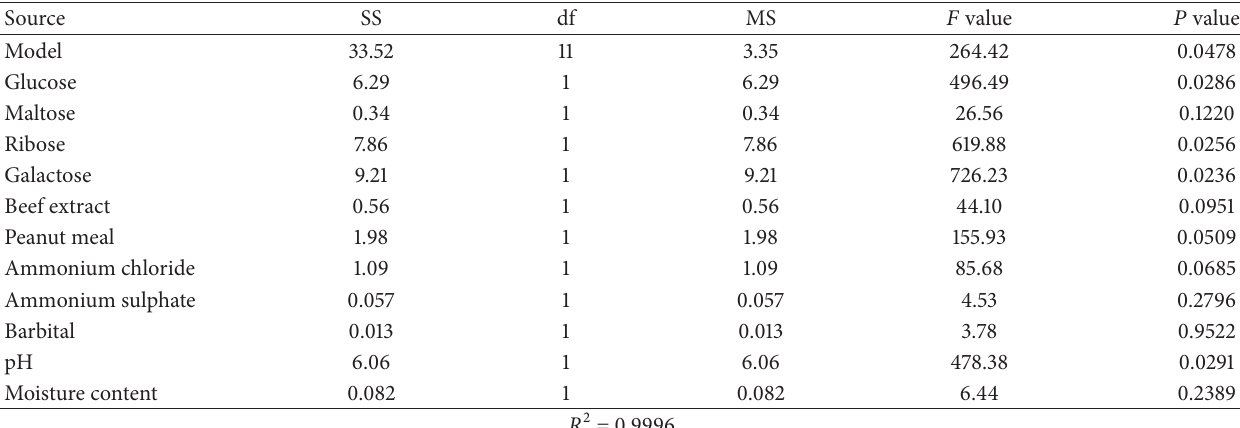
Table 3: ANOVA of Plackett-Burman design test data for the significant production